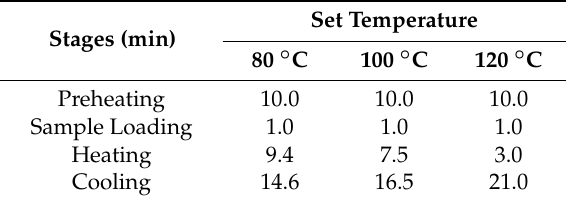
Table 1. Time allocation of each stage for wheat germ (WG) drying at 80–120 °C in the fluidized bed dryer.